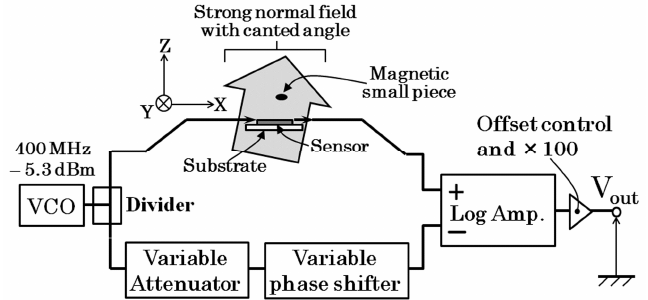
Figure 5. Proposed driving circuit of the thin-film